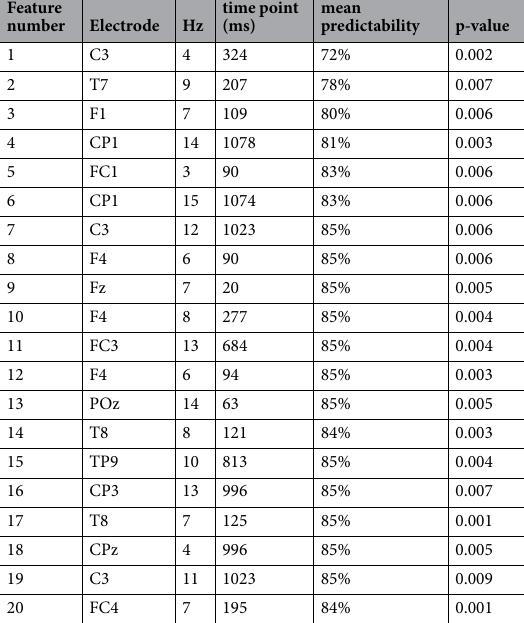
Table 3. Summary of the extracted features showing feature number, electrode site, frequency, time point in ms of the extracted feature after stimulus presentation, the mean predictability and the significance as provided from the t-tests used as a filter method in the feature selection